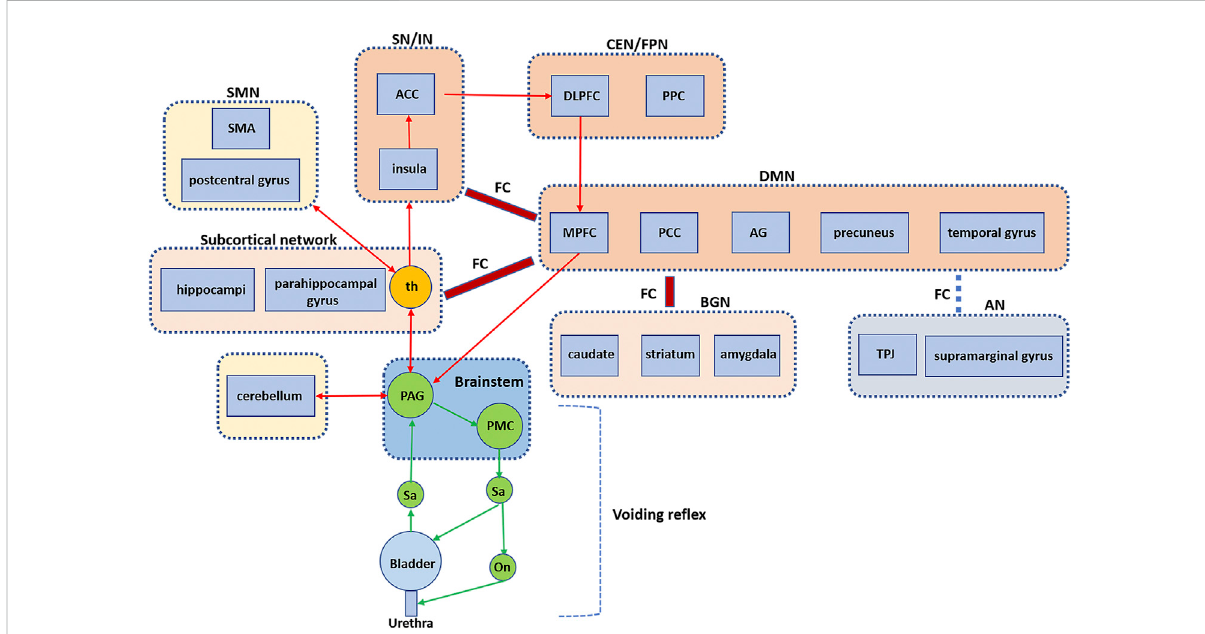
FIGURE 1 Brain FC and networks related to bladder control. An extended working mode showing the voiding re fl ex and the brain circuits, especially the interaction between brain regions and networks. FC, functional connectivity; PAG, periaqueductal gray; PMC, pontine micturition center; th, thalamus; SMA, supplementary motor area; SMN, sensorimotor network; ACC, anterior cingulate cortex; SN, salience network; IN, interoceptive network; DLPFC, dorsolateral prefrontal cortex; PPC, posterior parietal cortices; CEN, central executive network; FPN, frontoparietal network; MPFC = medial prefrontal cortex; PCC, posterior cingulate cortex; AG, angular gyrus; DMN, default mode network; BGN, basal ganglia network; AN, attentional network; TPJ, temporoparietal junction. (Extended based on working model by de Groat et al.,